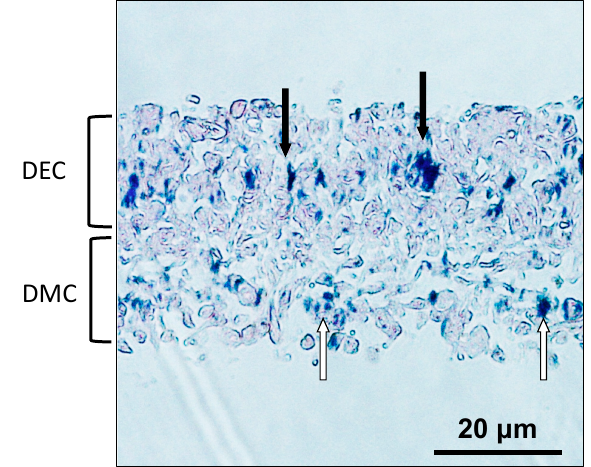
Figure 6. Microscopic observation of a CC sheet after iron staining (×200). Filled arrows indicate MNPs in the DEC layer. White arrows indicate MNPs in the DMC layer. Scale bar = 20 μ m. 2.7. Expression of mRNAs Encoding Enamel Matrix- and Dentin-Related Genes in CC Sheet